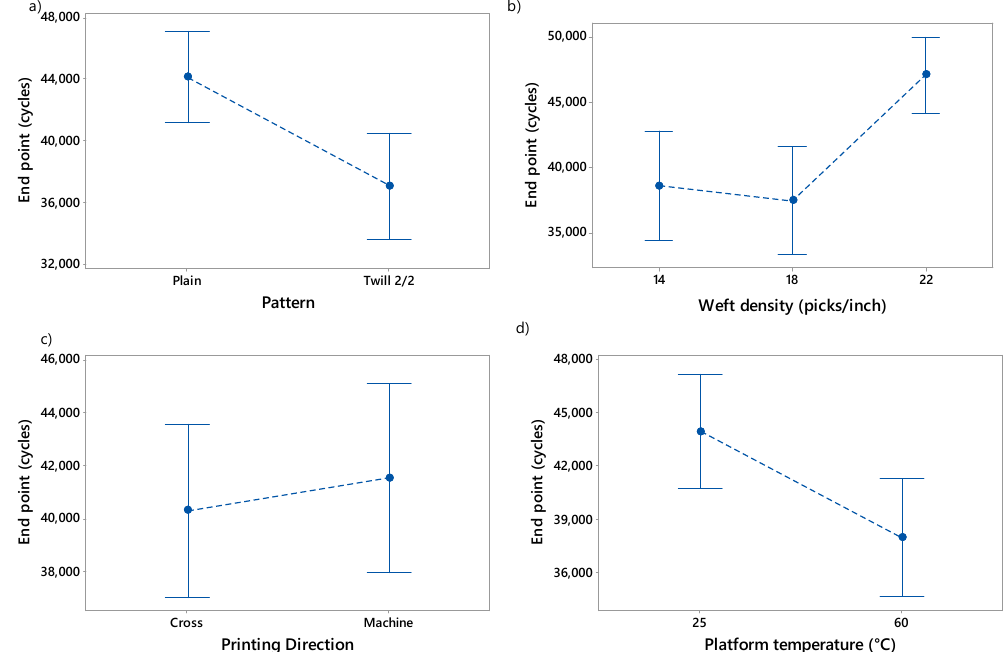
Figure 7. Influence of ( a ) fabric pattern, ( b ) weft density, ( c ) printing direction and ( d ) platform temperature on the end point which is the maximum number of cycles (cycles) of 3D-PPOT conductive materials.